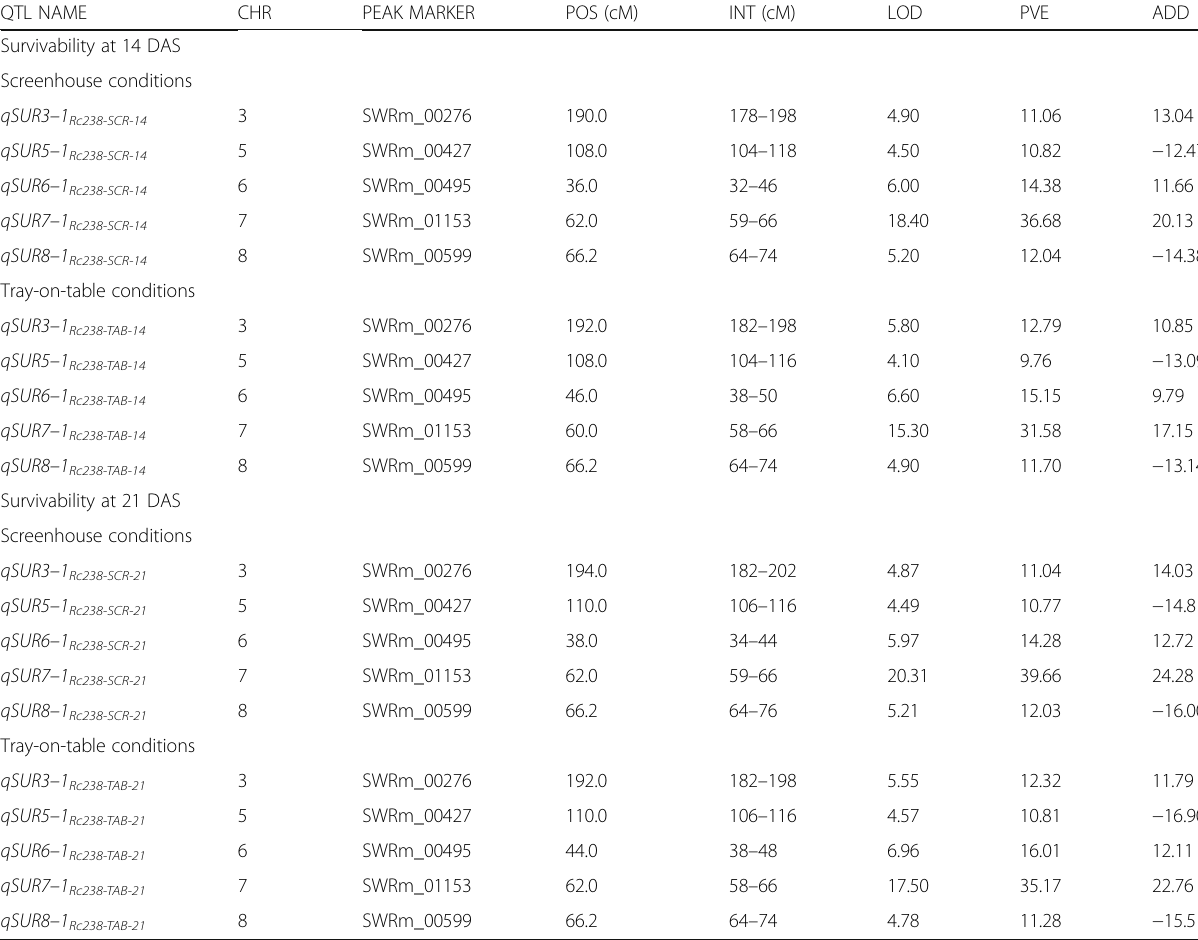
Table 2 List of QTLs Detected for Anaerobic Germination Potential in the BC 1 F 2:3 Population of Kalarata and NSIC